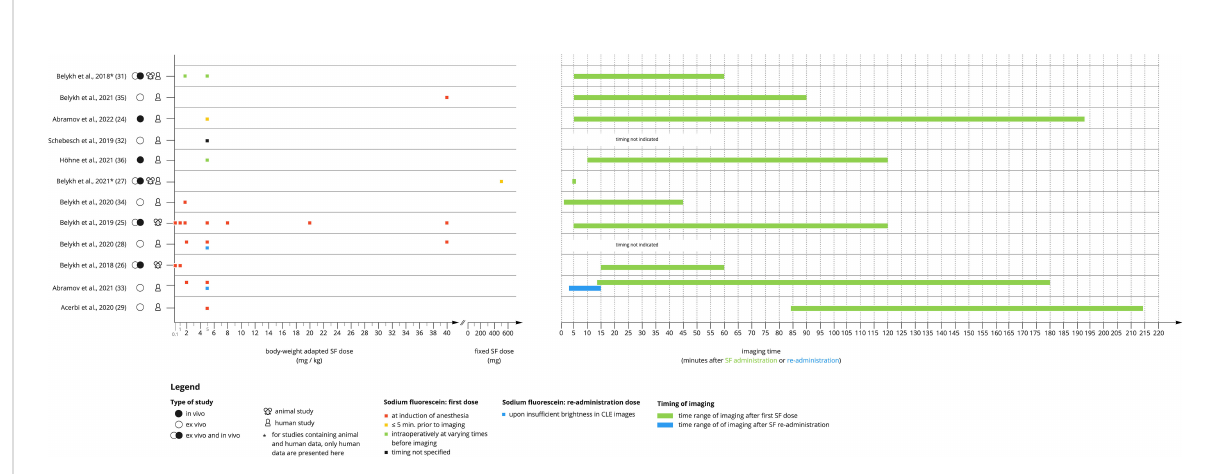
FIGURE 4 Graphical visualization of SF dosing protocols and timing of imaging in the different studies